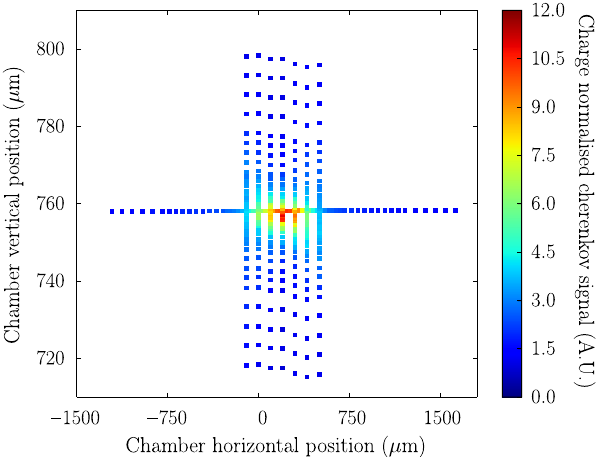
FIG. 24. Charge normalized Cherenkov signal sampled in multiple vertical laserwire scans at different horizontal positions. A long range horizontal scan is also